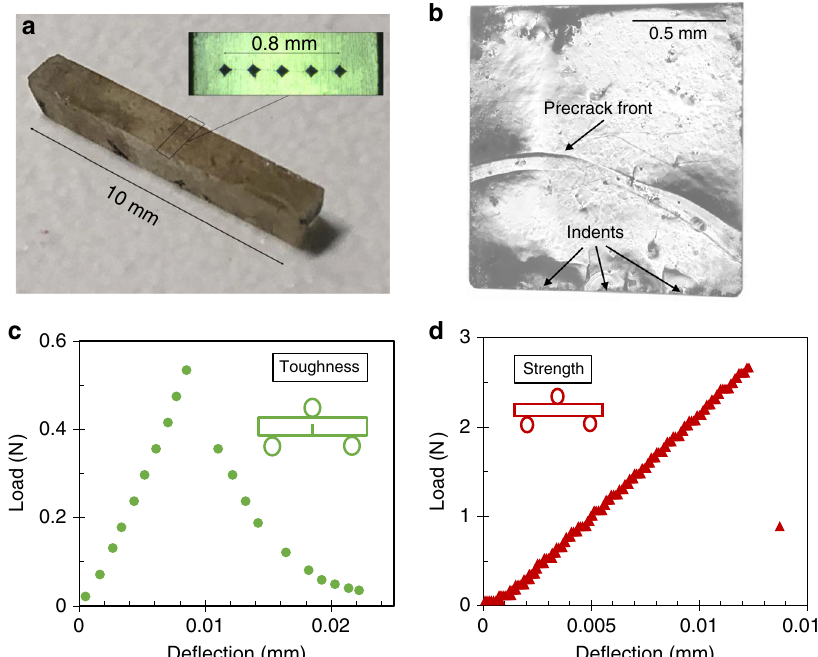
Fig. 2 Fracture toughness and strength measurement of ZIF-62 glass. a Example of an indented single-edge precracked beam (SEPB) specimen of ZIF-62 glass with dimensions of 1.5 × 1.9 × 10 mm 3 . The indentation line is enlarged and shown in the inset. b Post-fractured SEPB specimen. c Example of load- de fl ection curve of three-point bending on SEPB specimen. d Example of load-de fl ection curve of three-point bending on non-cracked specimen. Source data are provided as a Source Data fi